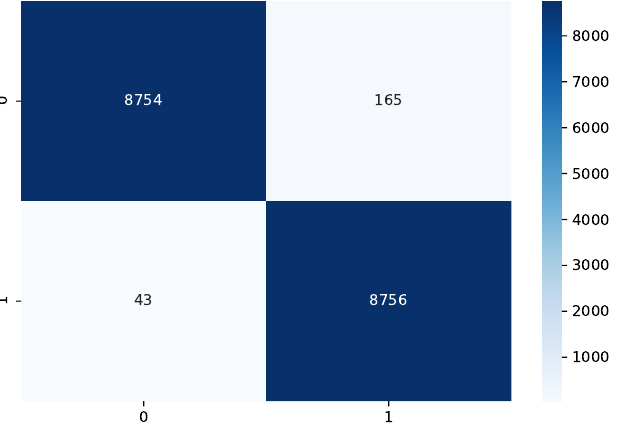
Figure 9. Confusion matrix analysis of the proposed model for human motion detection.